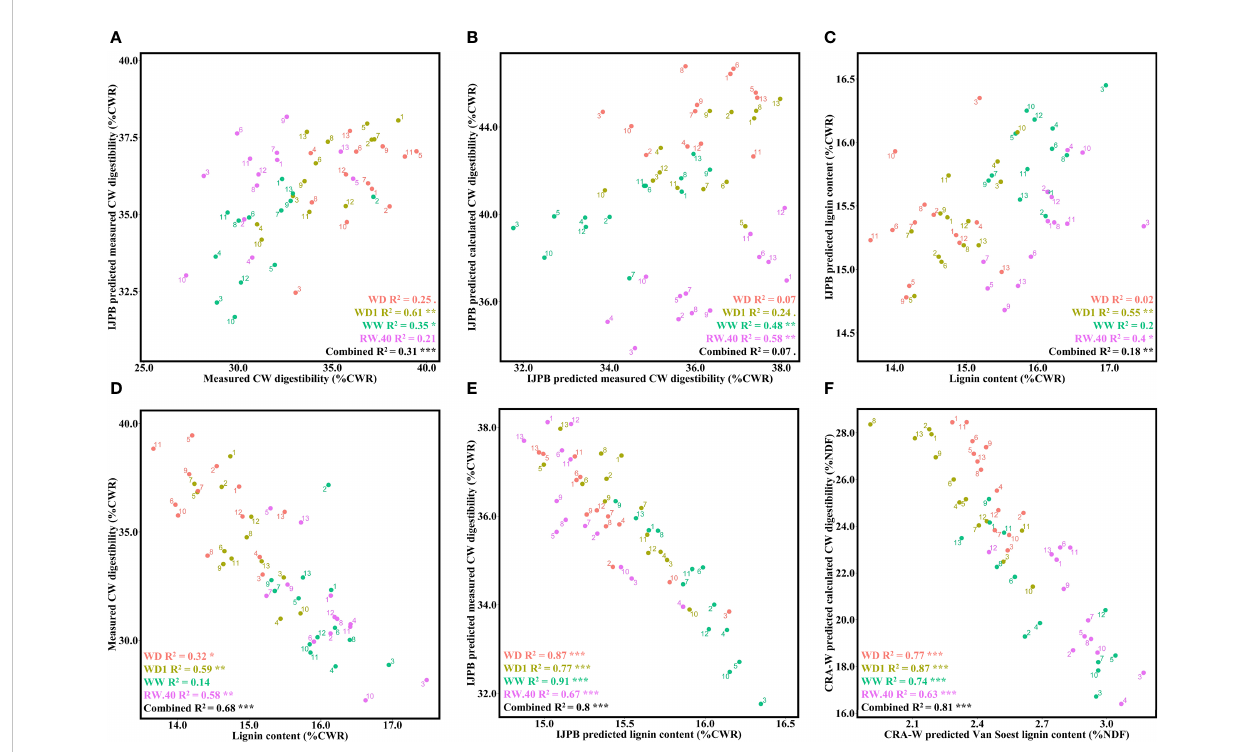
FIGURE 4 Lignin content and its role in CW digestibility and prediction of the relationship. (A) Relationship between laboratory-measured CW digestibility and IJPB-predicted measured CW digestibility. (B) Relationship between mean IJPB-predicted values for measured CW digestibility and IJPB-predicted calculated CW digestibility. (C) Relationship between laboratory-measured lignin content and IJPB-predicted lignin content. (D) Relationship between laboratory-measured lignin content and laboratory-measured CW digestibility on a representative block. (E) Relationship between mean IJPB-predicted values for lignin content and IJPB-predicted measured CW digestibility. (F) Relationship between CRA-W-predicted lignin content and CRA-W-predicted calculated CW digestibility. The dots denote the ratio values for the individuals, unless they are given as mean values, in which case they represent the mean values of the 3 blocks. Linear equation values are proceeded by Pearson correlation signi fi cance symbols: P <0.1:.; P <0.05: *; P <0.01: **; P <0.001: ***. The error bars represent the standard